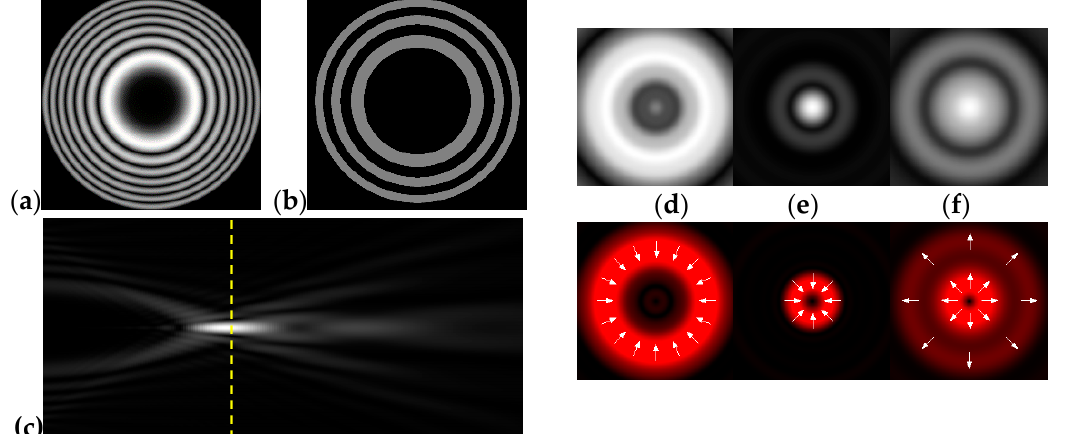
Figure 2. Simulation results for the field defined by Equation (1), which does not have any angular dependence: ( a ) amplitude and ( b ) phase of the input field ( x , y ∈ [ − 1 mm, 1 mm ] ); ( c ) longitudinal distribution of the amplitude ( z ∈ [ 20 mm, 500 mm ] , y ∈ [ − 1 mm, 1 mm ] ), and transverse patterns ( x , y ∈ [ − 0.25 mm, 0.25 mm ] ) of the field amplitude at different distances (top line): ( d ) z = 150 mm, ( e ) z foc = 200 mm, and ( f ) z = 250 mm, as well as the corresponding distributions of the transverse energy flow density (TEFD) amplitude in these planes (bottom line). The red color corresponds to the radial component | F ρ ( ρ , θ ) | , the blue color corresponds to the angular component | F θ ( ρ , θ ) | , and the arrows show the direction of flow.